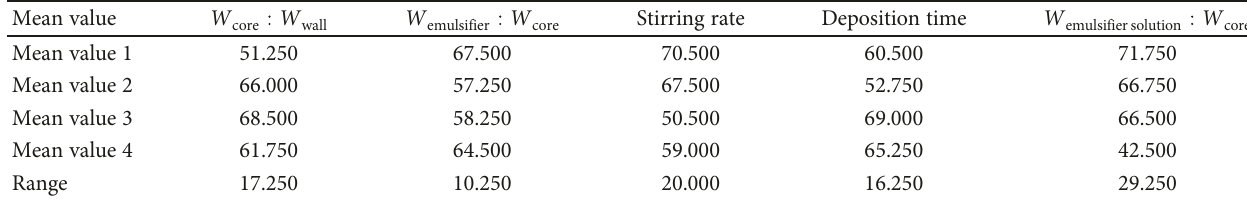
Table 8: Range of coverage rates of